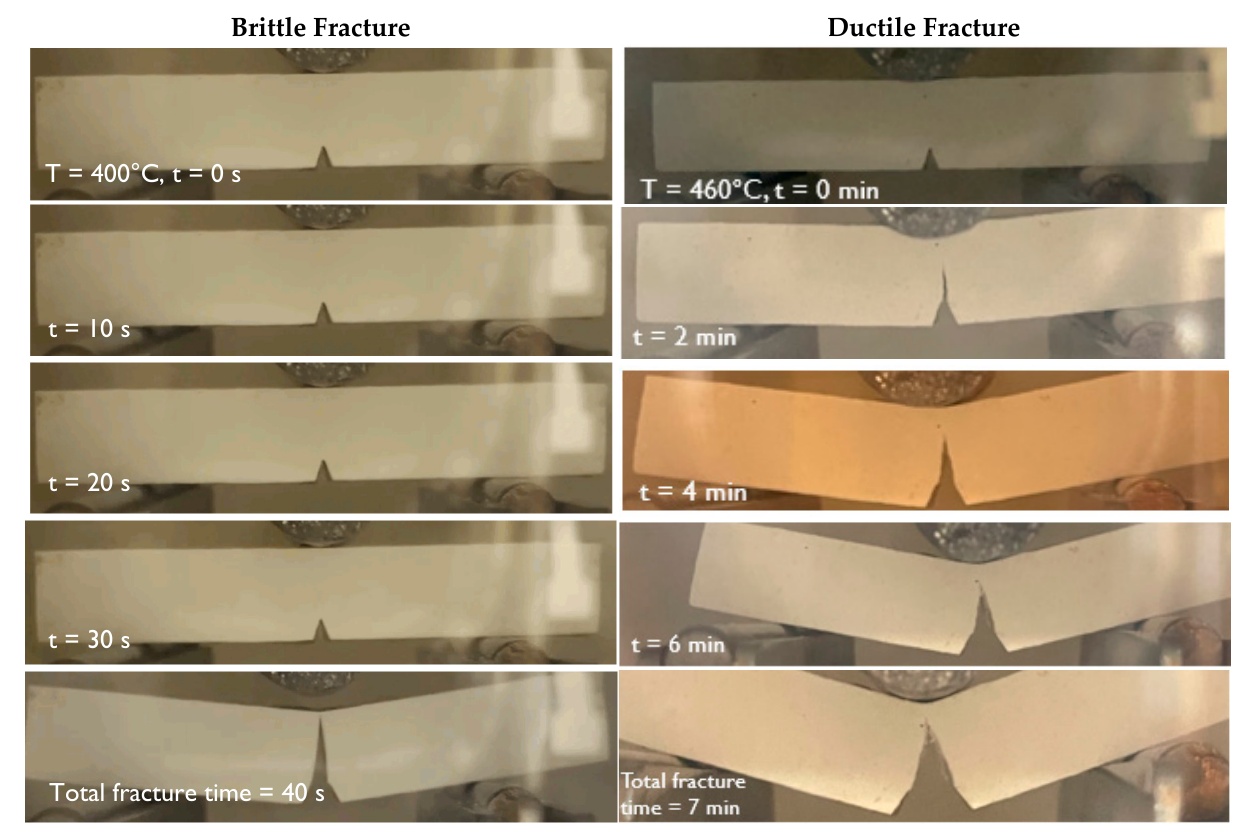
Figure 8. Comparison of two specimens tested at 400 °C and 460 °C, respectively.